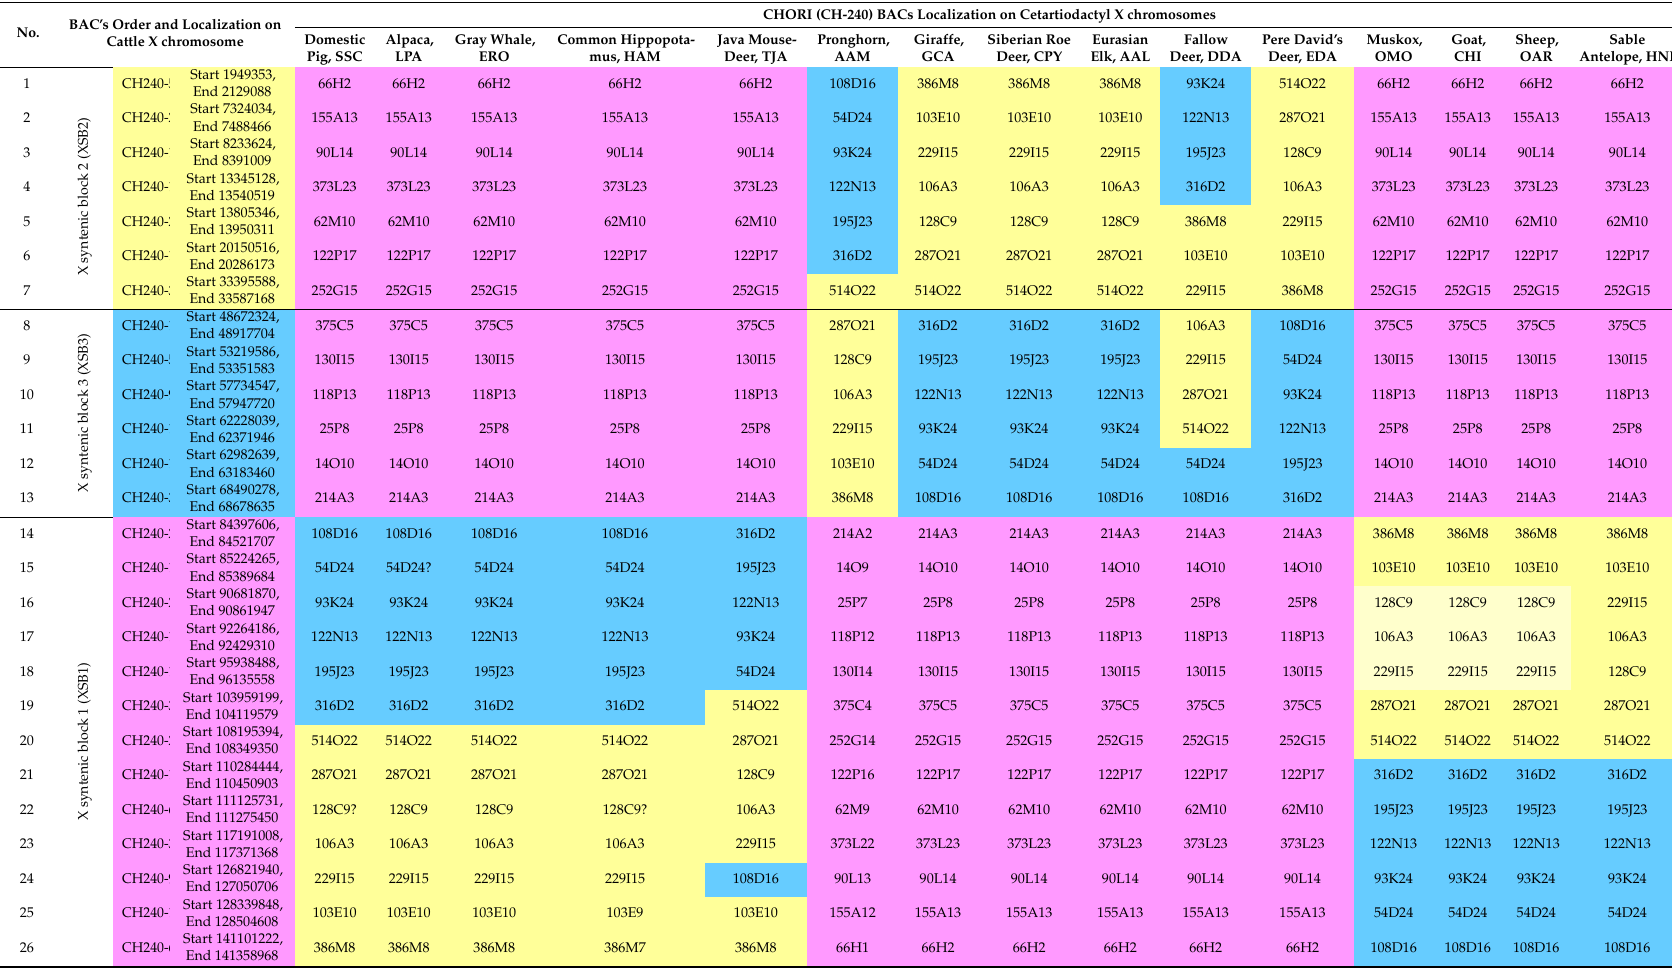
Table 2. CHORI-240 BAC’s order on cetartiodactyl X chromosomes. The color of the cells corresponds to a certain conservative syntenic